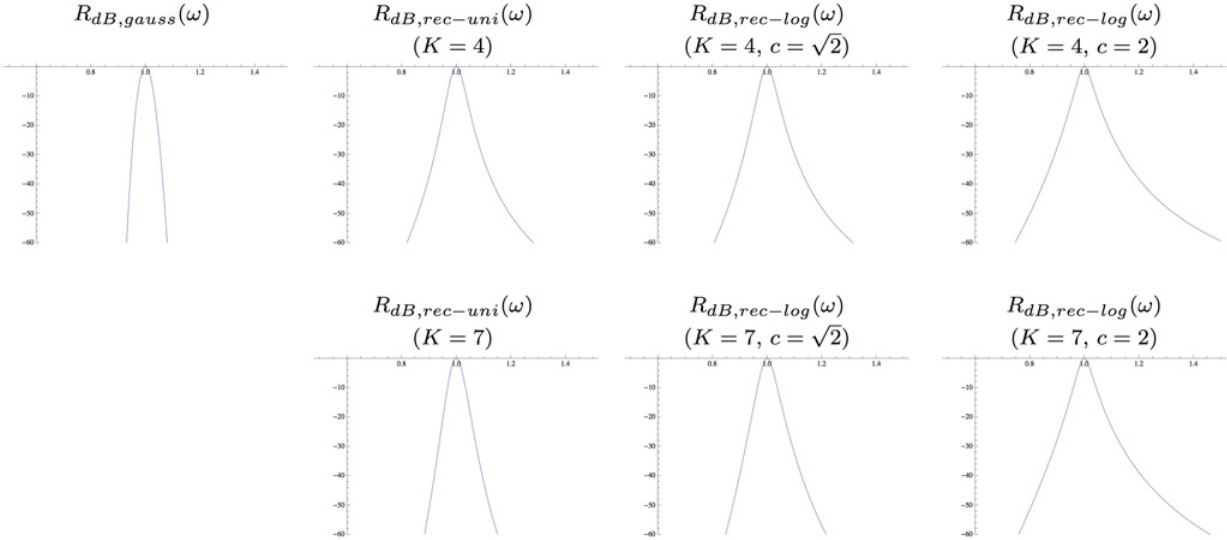
Fig 21. Graphs of the frequency selectivities of Gaussian and time-causal window functions with the temporal extent proportional to the corresponding wavelength of the spectrogram with n = 8. For the time-causal filters, K = 4 or K = 7 filters have been coupled in cascade. For the logarithmic distribution, the ratio between successive temporal scale levels τ k = c 2( k − K ) τ has been determined from c ¼ frequency ω in units of ω 0 . Vertical axis: dB values down to -60